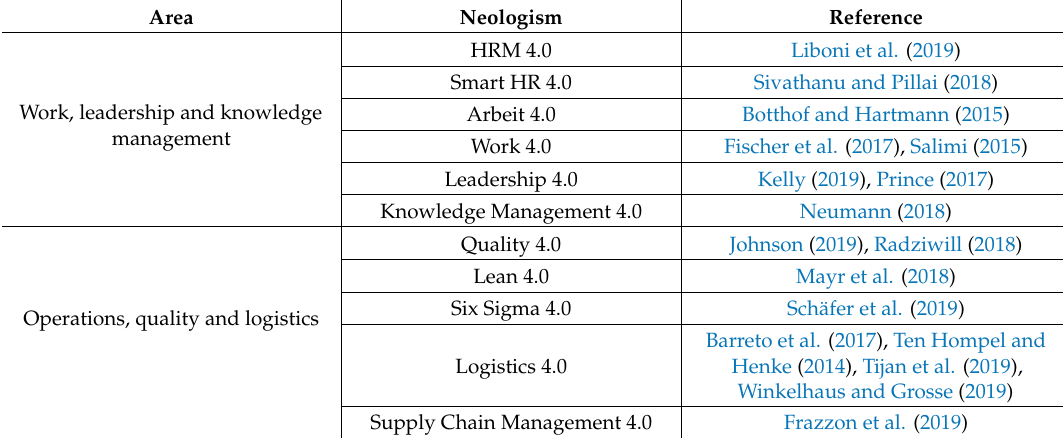
Table 2. Neologisms inspired by the I4.0 concept (Source: Author’s own